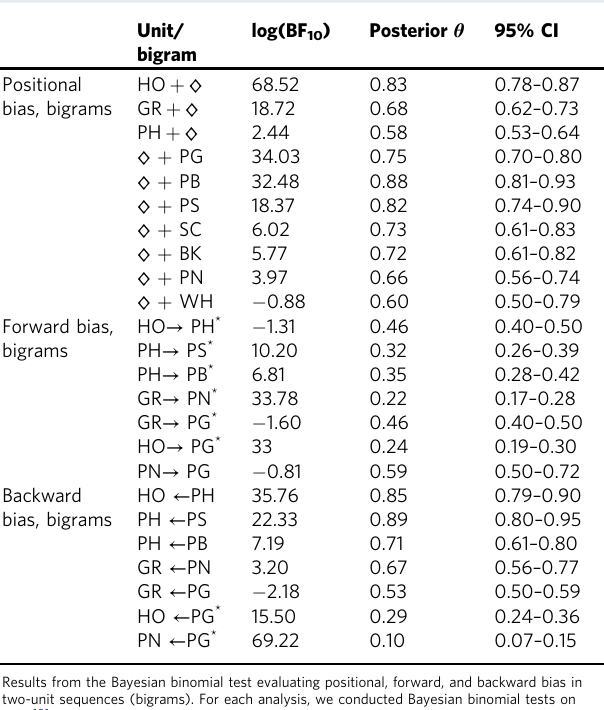
Table 3 Bayesian binomial test for positional, forward, and backward bias in two-unit sequences